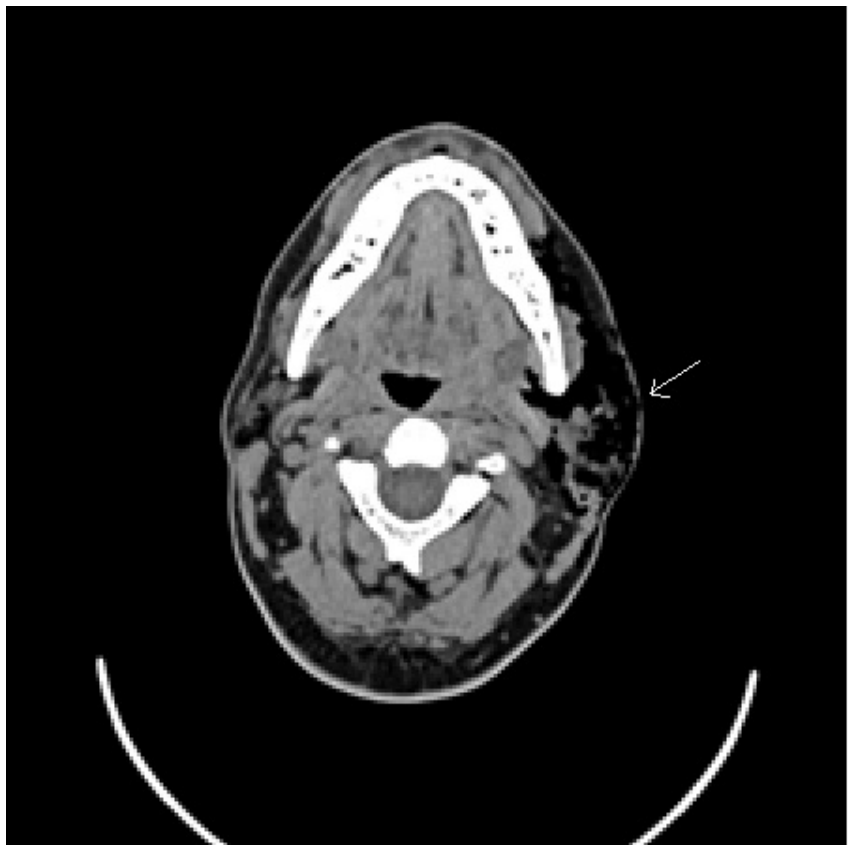
Figure 1. Axial projection computed tomography (CT) image of a left pneumoparotid case, with the arrow indicating the presence of air in the parotid lodge.